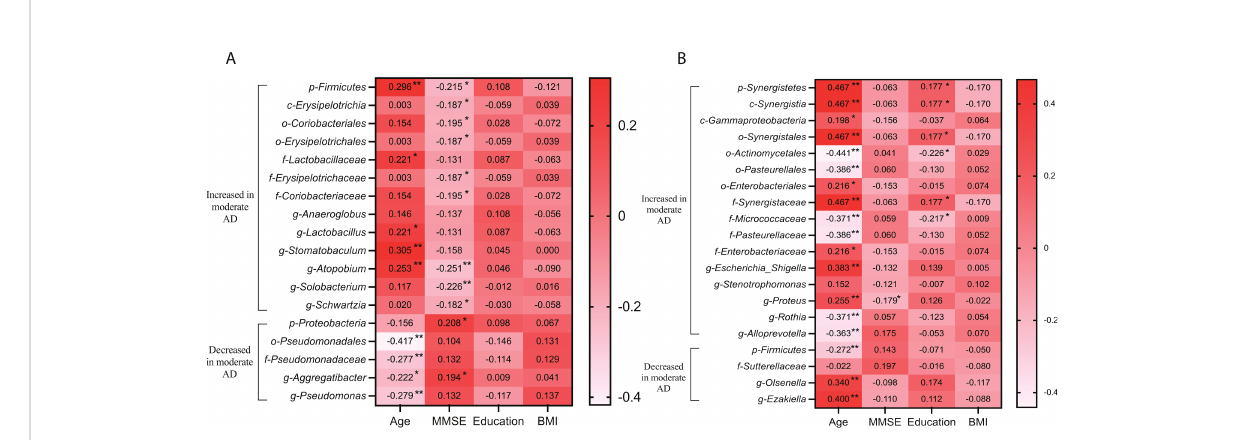
FIGURE 6 Correlations of altered oral (A) and gut (B) microbiomes with clinical characteristics in mild and moderate AD groups. Spearman ’ s rank correlation coef fi cient (R) and probability ( p ) were used to evaluate statistical importance. R-value showing the correlation between the microbiota and clinical factor, with signi fi cant p -values indicated. * p < 0.05, ** p < 0.01; BMI, body mass index; MMSE, mini-mental state